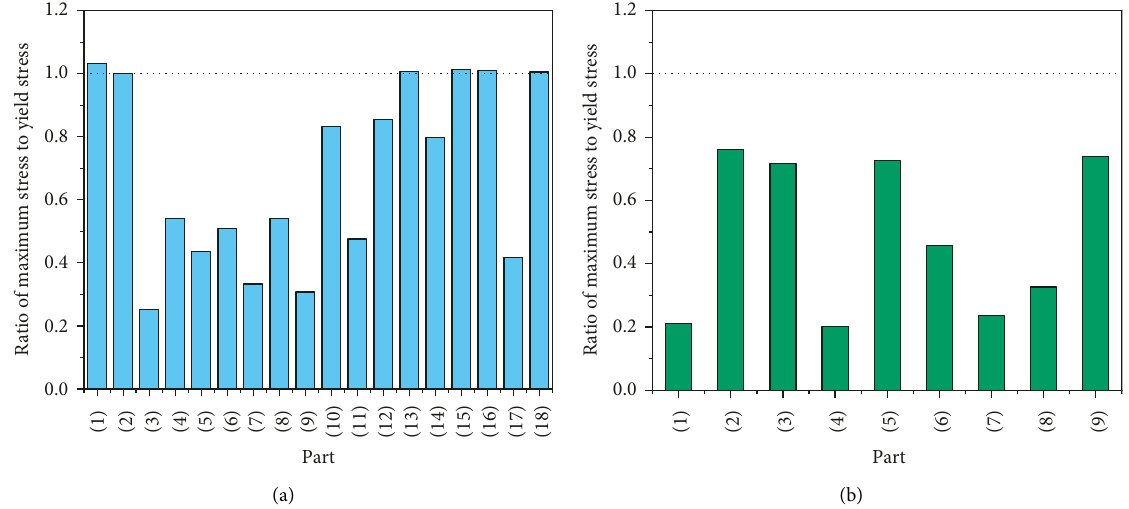
Figure 27: The ratio of maximum stress to yield stress of parts: (a) Tension string; (b) Suspension string.